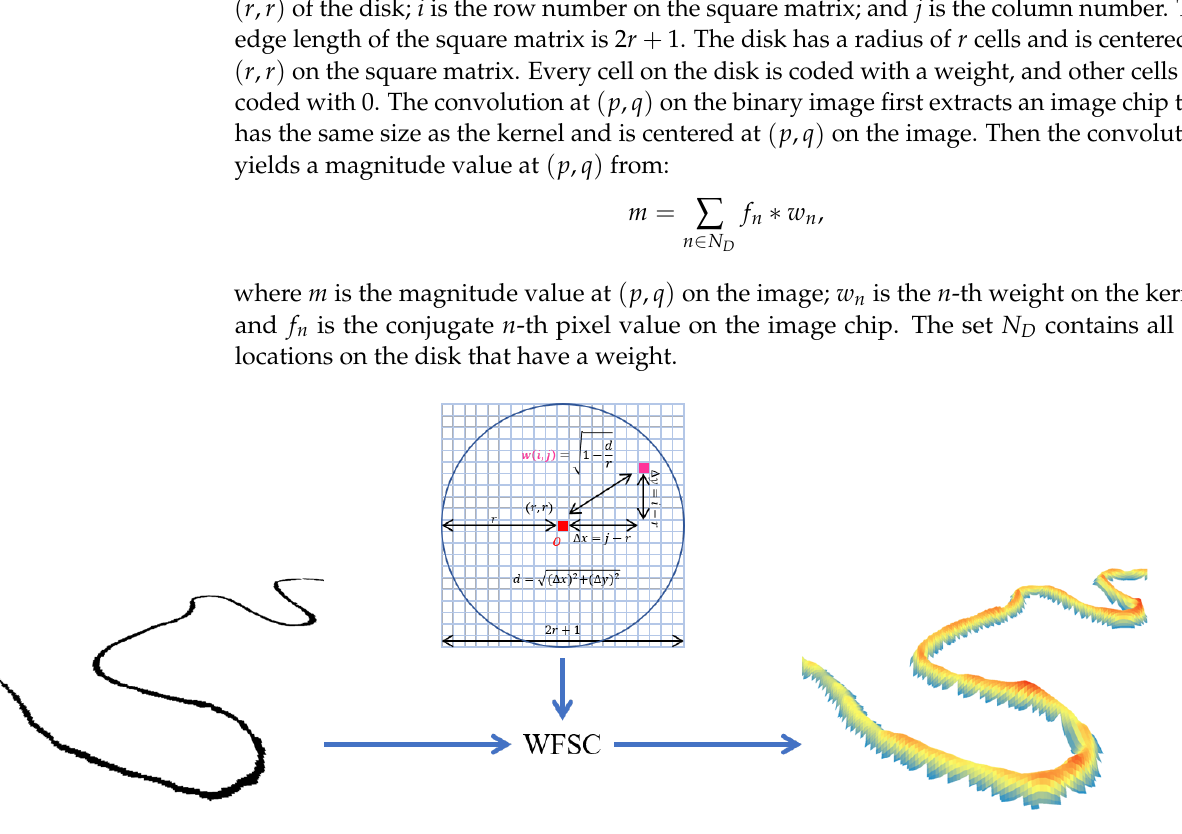
Figure 3. An example of the weighted focal statistic filter and the WFSC. The WFSC converts the lotic habitat image object in the binary raster representation into a continuous magnitude surface, and the centerline of the lotic habitat image object/link corresponds well to the ridgeline on the magnitude surface.